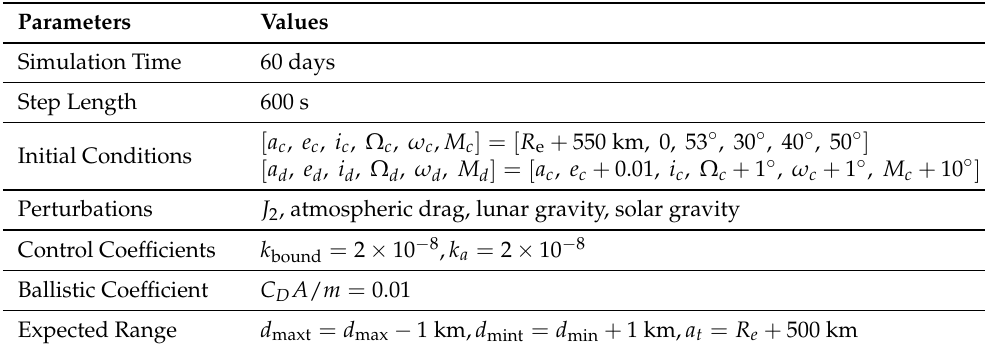
Table 2. Simulation parameters for the two-satellites case.